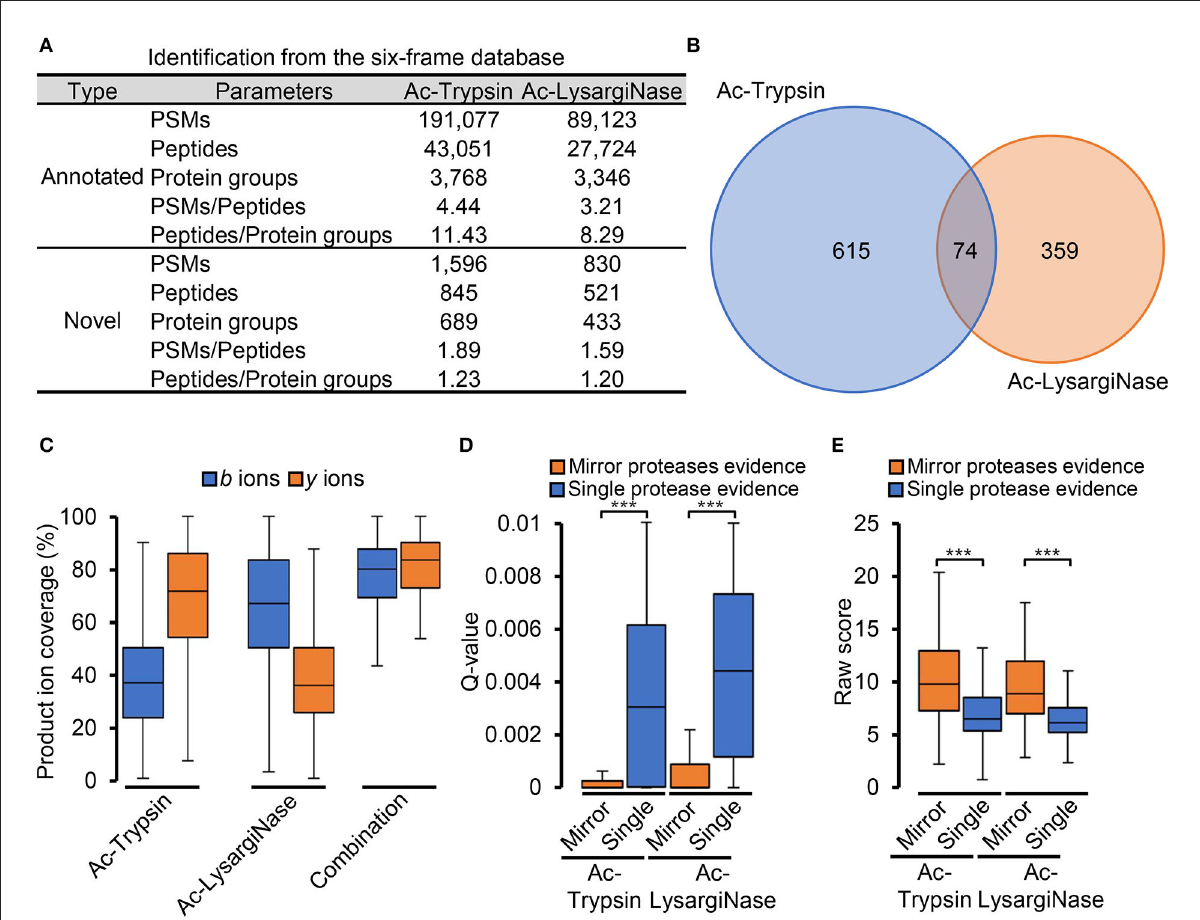
FIGURE3 Mirror proteases efficiently identified credible novel peptides. (A) The proteogenomic identification is based on the six-frame database of M. smegmatis MC 2 155. (B) Venn diagram of the proteins identified from the Ac-Trypsin and Ac-LysargiNase datasets. (C) Comparison of the ion coverages from single protease and combined mirror proteases for novel peptides. Comparison of the Q -value (D) and raw score (E) spectra with single protease and mirror proteases digesting evidence from the Ac-Trypsin and Ac-LysargiNase